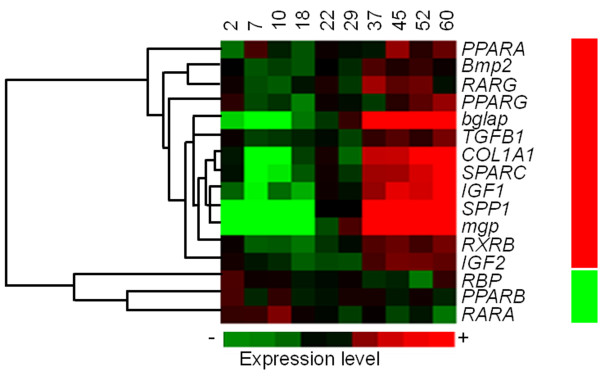
Hierarchical clustering of the 16 target genes analysed based on mRNA expression, showing the cluster of the different studied genes with similar expression profile during larval development. Columns represent the mean data values for each of the 10 sampling times (days post hatching; dph) and rows represent single genes. Expression level of each gene is represented relative to its median abundance across the different stages and is depicted by a colour scale: green, black, and red indicating low, medium, and high relative expression levels, respectively. Coloured bars to the right indicate the location of two gene clusters: red corresponds to genes with a progressive increase in mean gene expression level from 2 to 60 dph; and green with those whose mean gene expression level decreased progressively from an initial relative high level of expression.